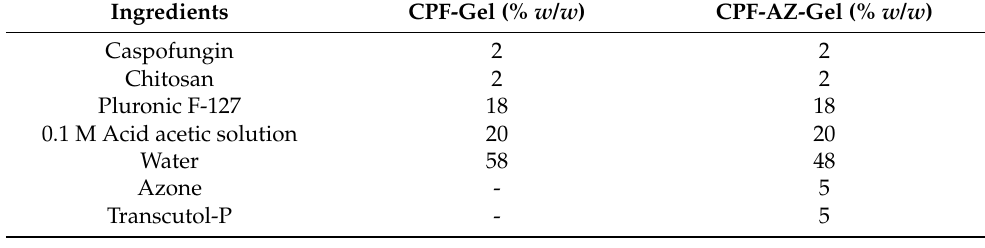
Table 1. Composition formula of caspofungin-loaded gels.